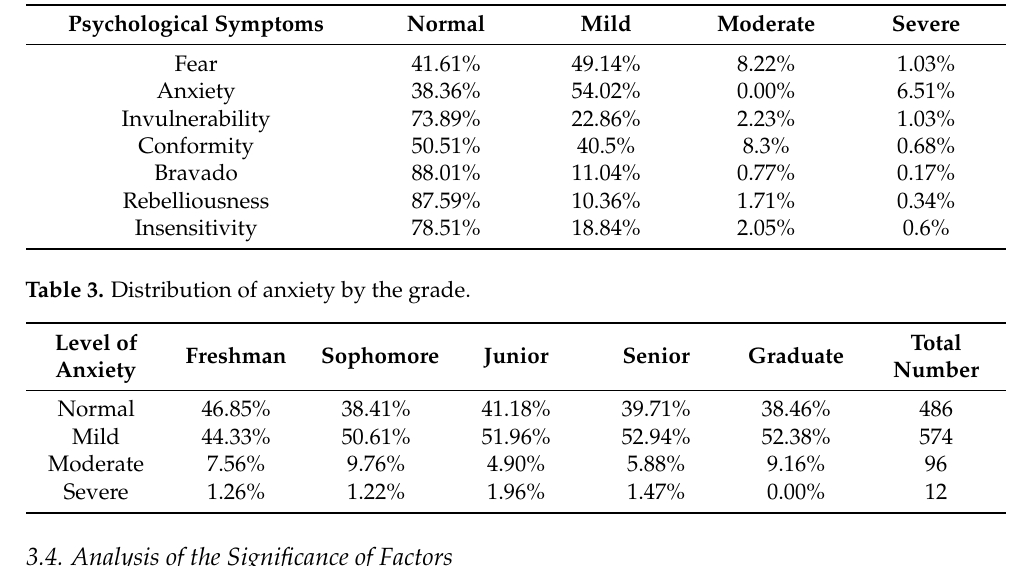
Table 2. Psychological symptoms of college students during the COVID-19 epidemic.